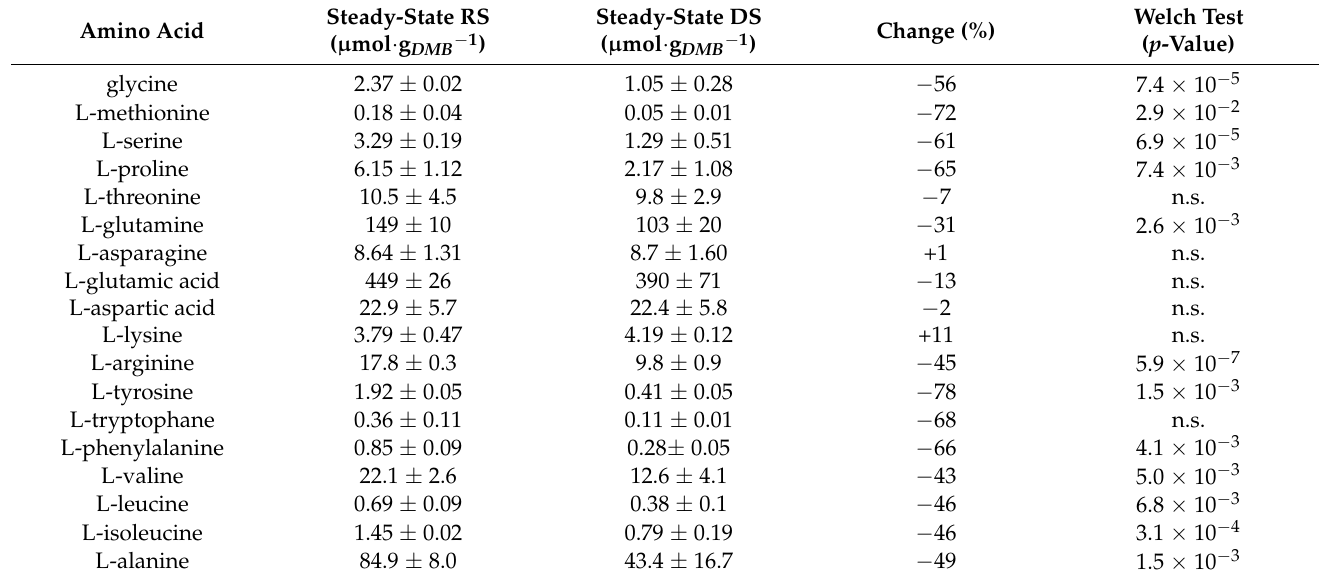
Table A2. Amino acid concentrations during reference and dynamic steady-state conditions. For the dynamic steady state, average pool concentrations over one perturbation cycle were reported.